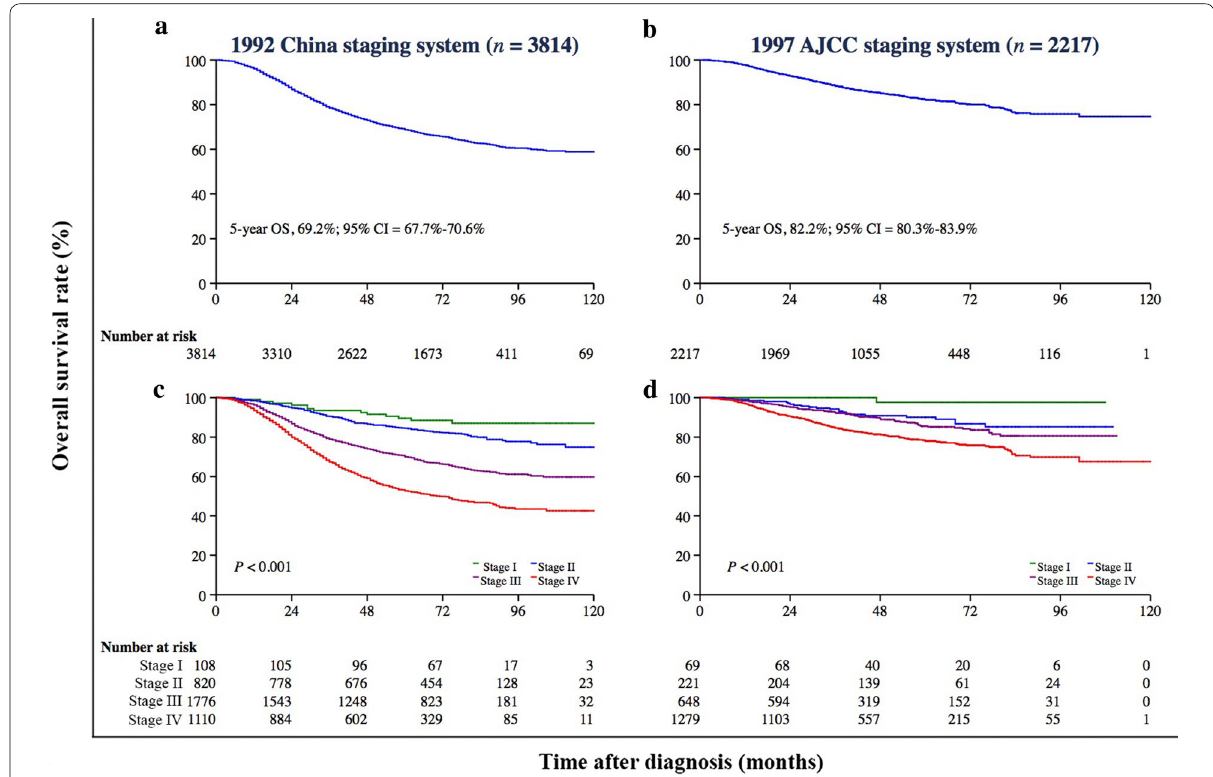
Fig. 4 Kaplan‑Meier survival estimates for NPC patients according to two different staging systems. In all, 3814 (63.2%) NPC patients from mainland China were diagnosed before 2006 and were staged according to the 1992 China staging system, whereas 2217 (36.8%) from Hong Kong, Taiwan, Singapore, and SYSUCC (in mainland China) were diagnosed between 2007 and 2011 and were staged according to the 1997 AJCC staging system. The 5‑year OS rate was 69.2% (95% CI 67.7%–70.6%) for patients classified by the 1992 China staging system ( a ) and 82.2% (95% CI = 83.9%) for patients classified by the 1997 AJCC staging system ( b ). The OS differed significantly by clinical stage according to the 1992 China staging system ( P < 0.001, c ) and the 1997 AJCC staging system ( P < 0.001, d ). The log‑rank test was used to calculate P values